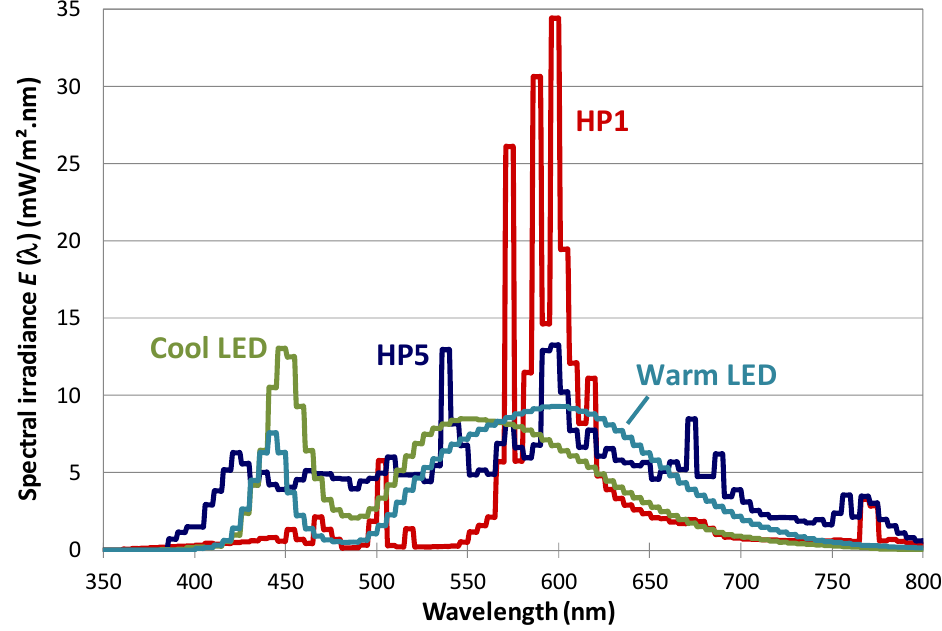
Figure 3. The spectral irradiance E ( λ ) of illuminant HP1 for a high pressure sodium lamp, illuminant HP5 for a metal halide lamp, and a standard cool and warm LED spectrum for typical LED lights, all scaled to 500